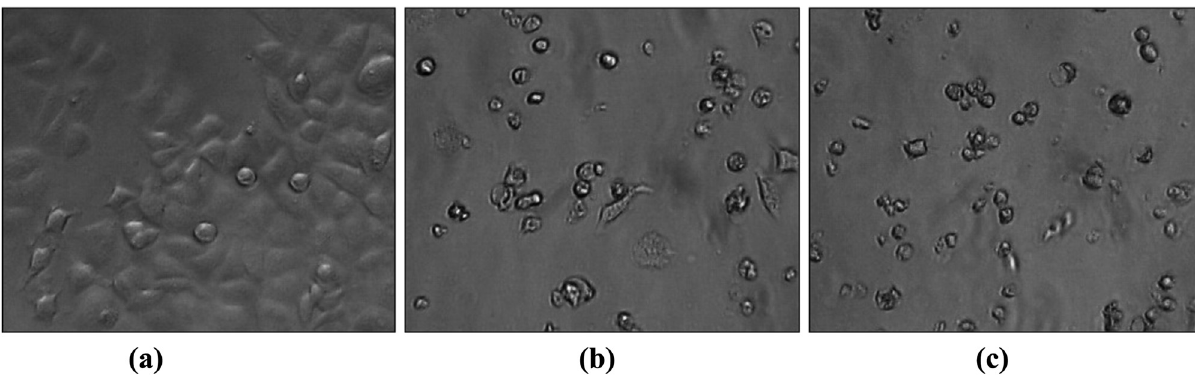
( Figure 7 ) ( Jaksic, 2012 ) . The percentage of apoptotic and